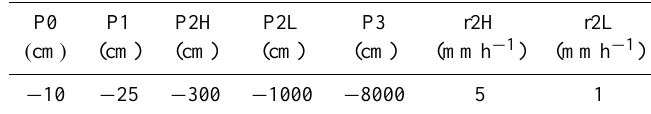
Table B1. Parameters of the water stress reduction function used in the Hydrus 1-D model.